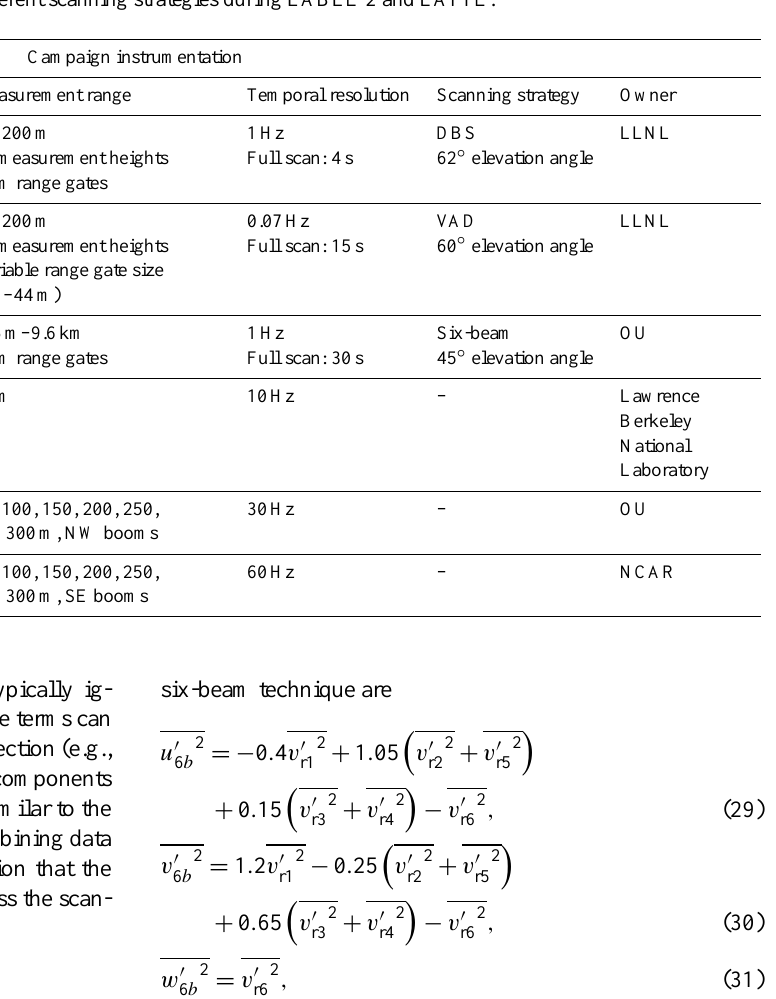
Table 1. Overview of instruments used to evaluate different scanning strategies during LABLE 2 and